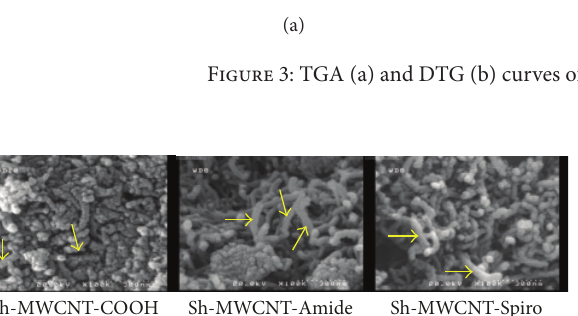
Figure 4: The FESEM images of modified Sh-MWCNTs. The yellow arrows in Sh-MWCNT-Amide and Sh-MWCNT-Spiro show a slight increase in thickness on the surface of tubes with respect to Sh- MWCNT-COOH.